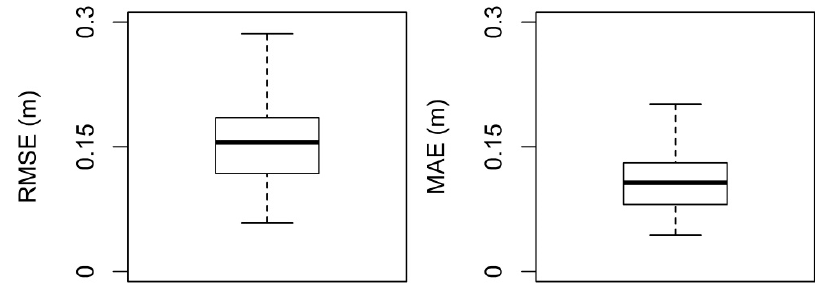
Figure 4. Comparing ability of the bathymetric model (with ideal parameters) to represent a measured cross-section. Shown are variances of root mean square error (RMSE) and mean absolute error (MAE) values.